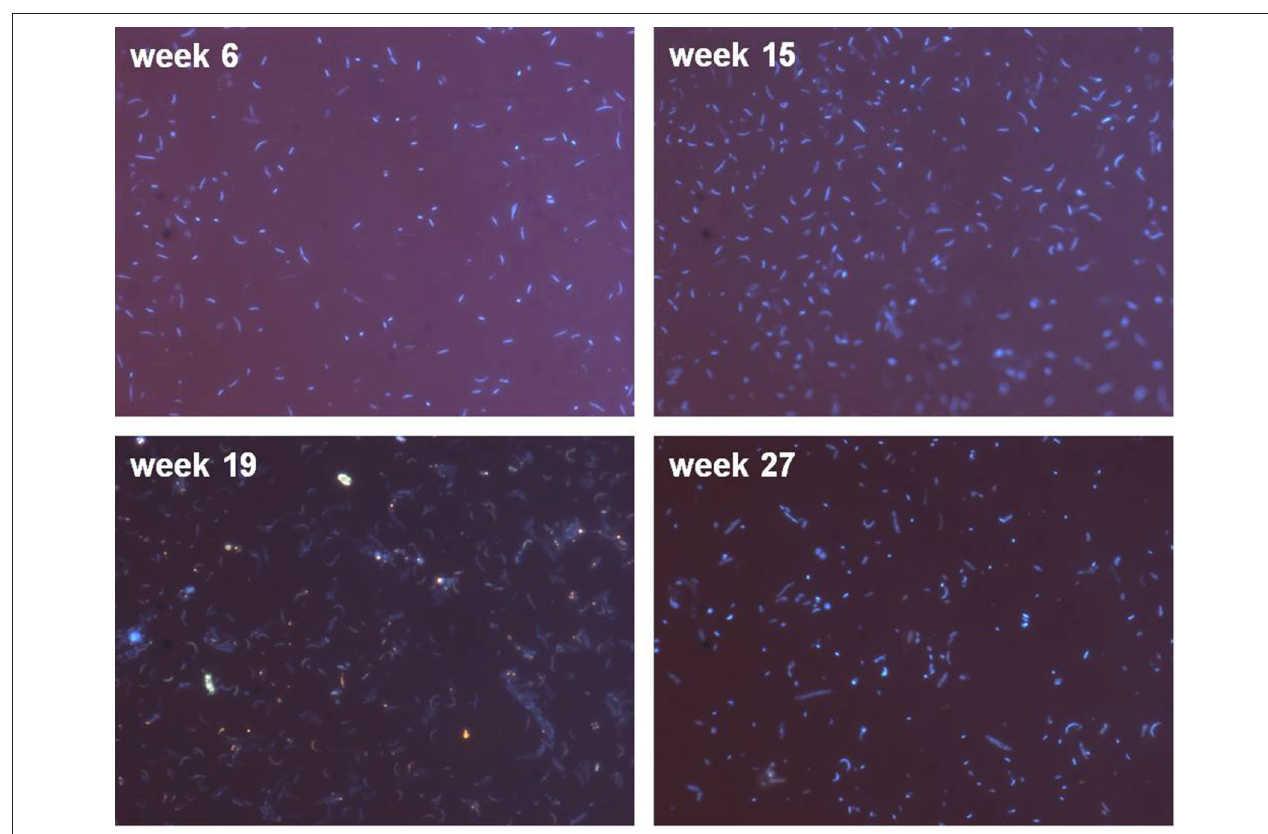
FIGURE 5 | Microscopic examination (1000-fold magnification) of DAPI stained cells showing coccoid- and rod-shaped bacteria. Please note that in order to achieve evaluable fluorescence pictures, the microscopy pictures were obtained with different filtration volumes (week 6 and 27: 2ml; week 15 and 19: 7ml) to account for varying cell numbers during the bioreactor runtime.